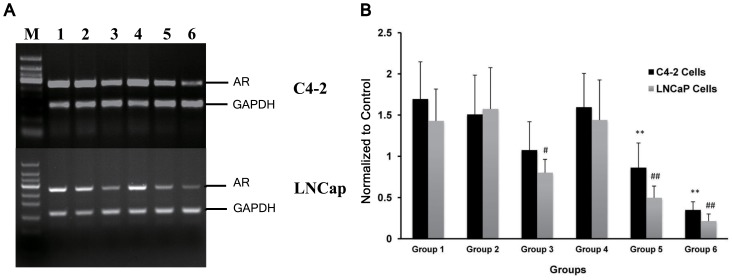
Electrophoresis results for RT-PCR products.Lanes 1–6 represent Groups 1–6, respectively (Group1: siRNA+NB, Group2: siRNA-NB, Group3: siRNA+US, Group4: NB+US, Group5: siRNA+NB+US, Group6: siRNA-NB+US). The sizes of the markers (the M lane, from bottom to top) are 50, 100, 150, 200, 250, 300, 350, 400, and 450 bp. GAPDH served as an internal reference. The highest suppression of AR mRNA expression was observed in Group 6. (A) and (B): Bands of RT-PCR products and the results of image quantification; the data in the histograms represent the means ± SD of five independent experiments. (* P<0.05 and ** P<0.01 vs. Group 1 C4-2 cells; # P<0.05 and ## P<0.01 vs. Group 1 LNCaP cells).